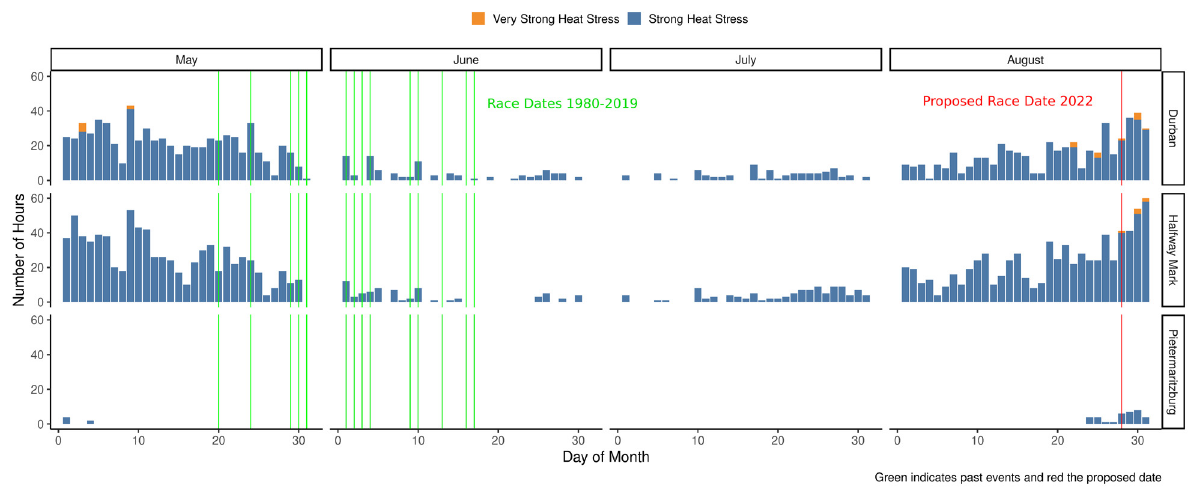
Figure 3: Cumulative hours of historical heat stress occurrences, per day, from the beginning of May to end of August